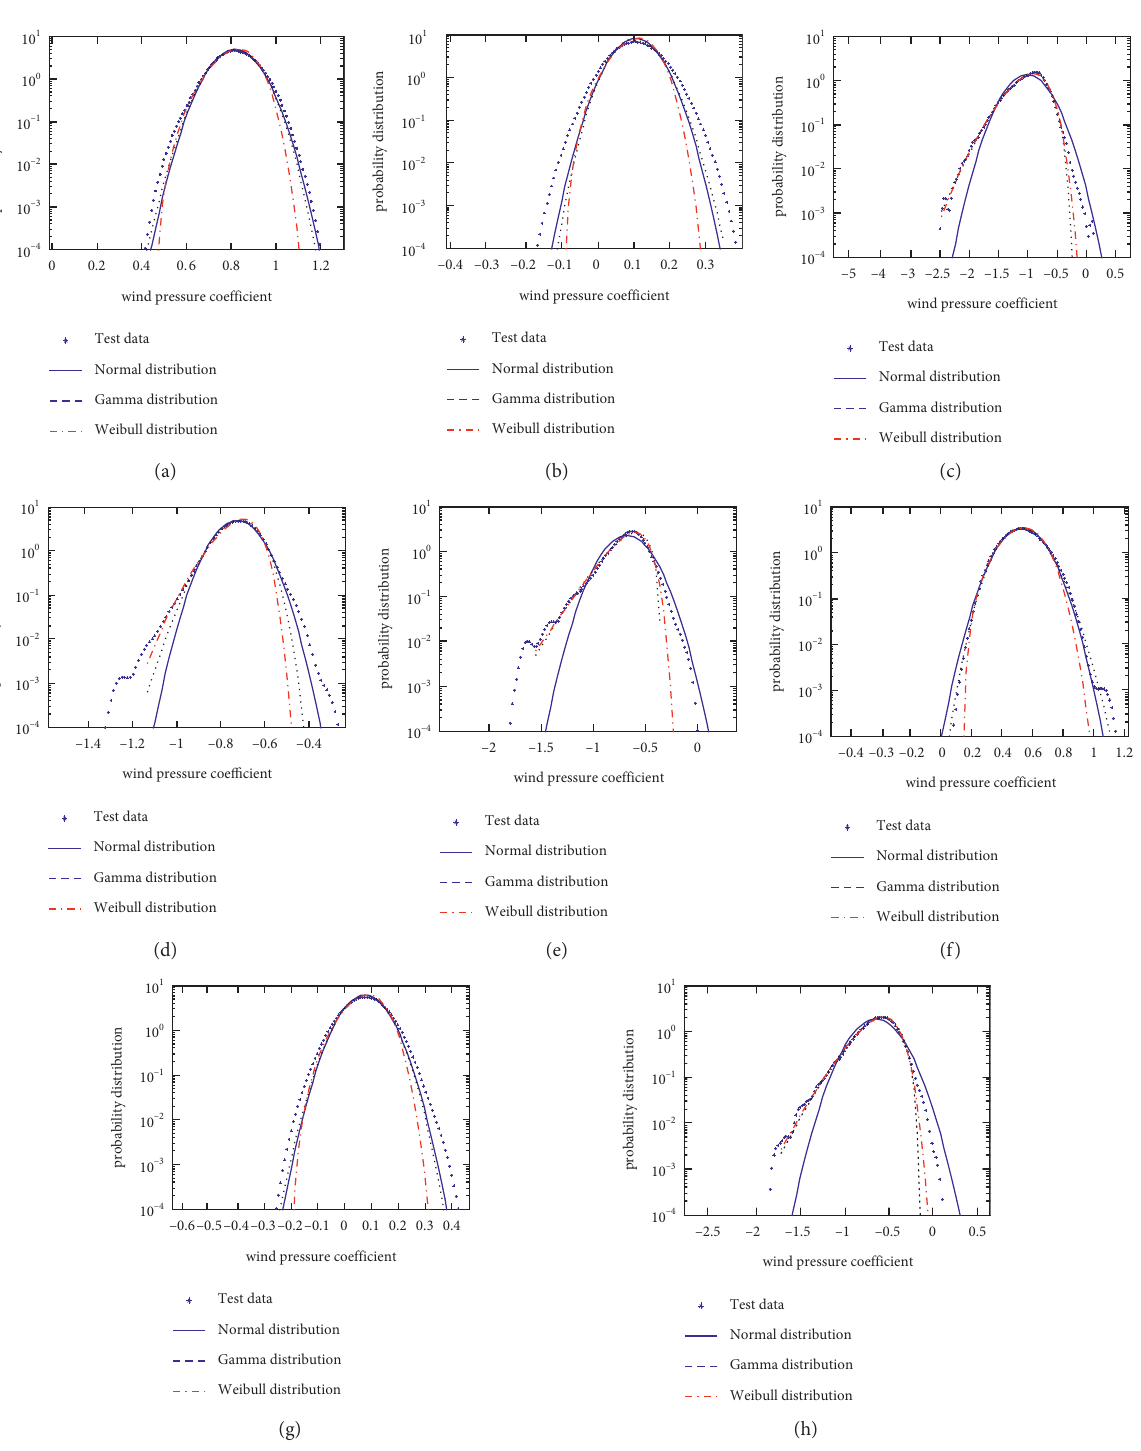
Figure 16: Probability density fitting diagram of wind pressure coefficient at typical measurement points. (a) 0 ° measurement point 28–39. (b) 45 ° measurement point 28–39. (c) 90 ° measurement point 28–39. (d) 135 ° measurement point 28–39. (e) 180 ° measurement point 28–39. (f) 45 ° measurement point 5-3. (g) 90 ° measurement point 5-3. (h) 135 ° measurement point